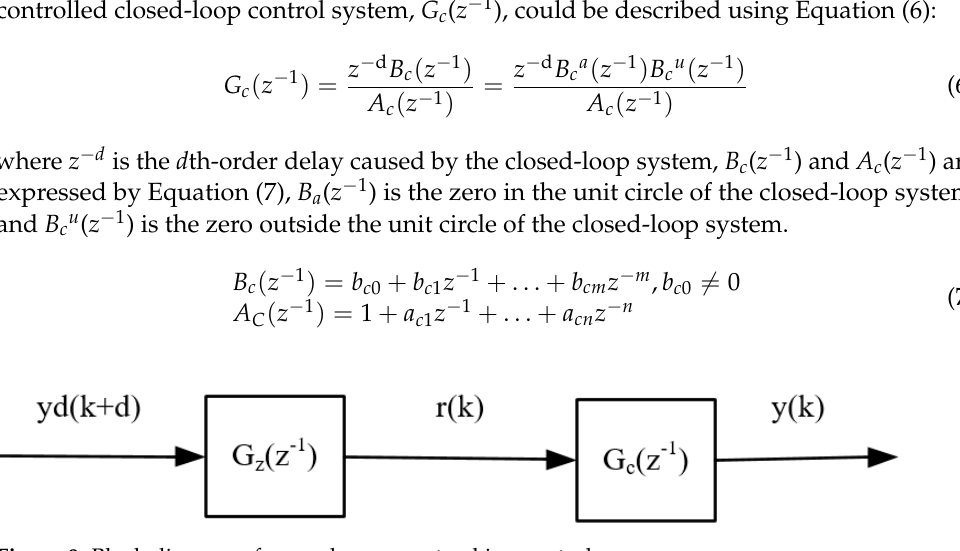
Figure 9. Block diagram of zero-phase error tracking control.